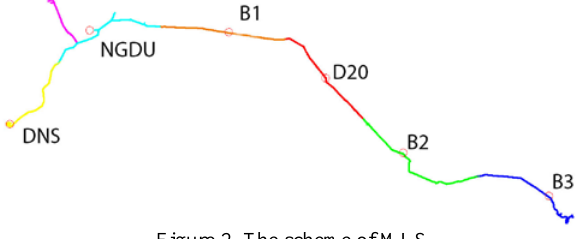
Figure 2. The scheme of MLS